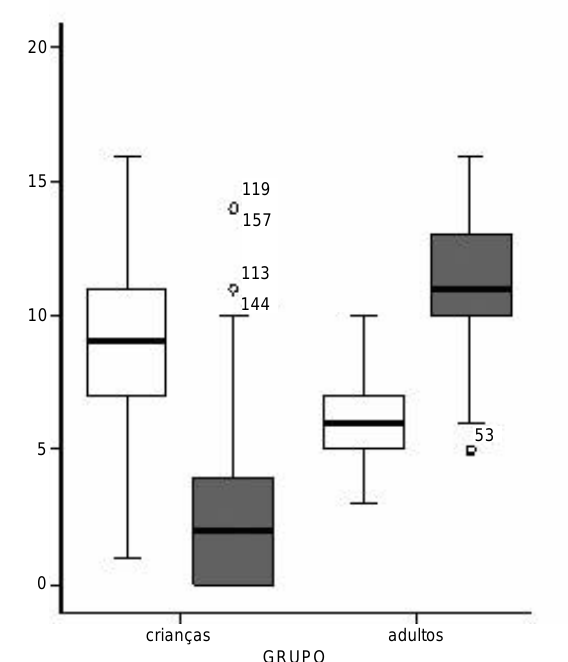
Figura 2. Freqüência de verbos genéricos nas respostas de crianças e adultos nas Tarefas de Nomeação e de Reformulação de Ações: Em branco, Tarefa de Nomeação; em cinza, Tarefa de